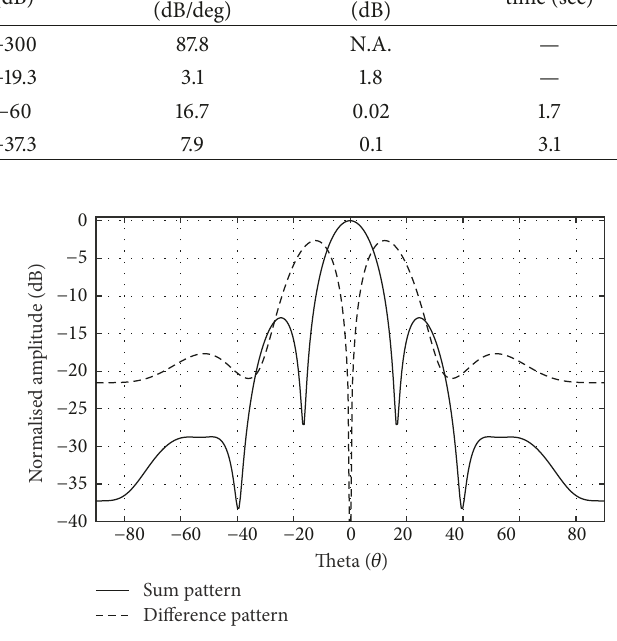
Figure 9: Optimised sum and difference